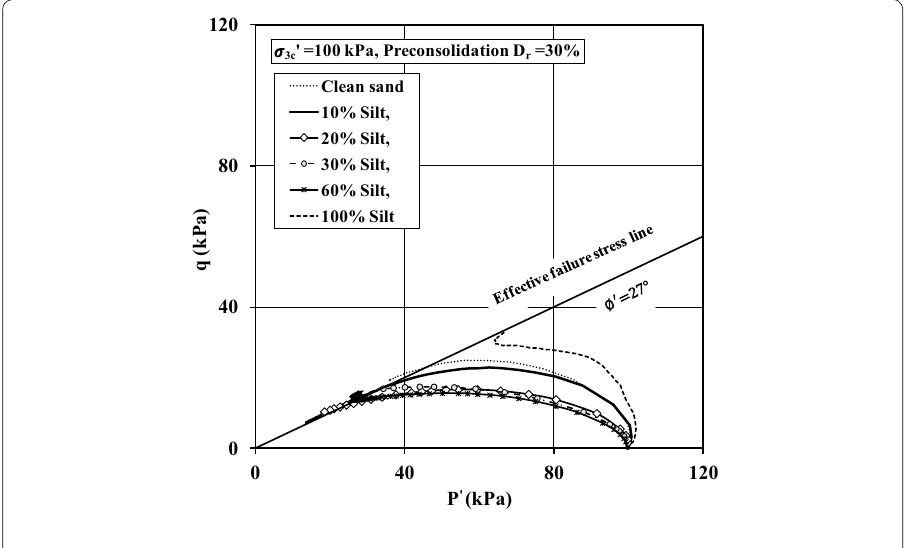
Fig. 11 Effective stress path of tested specimens at 30% relative